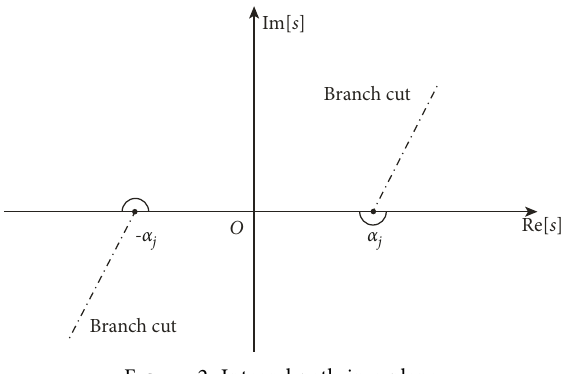
Figure 2: Integral path in